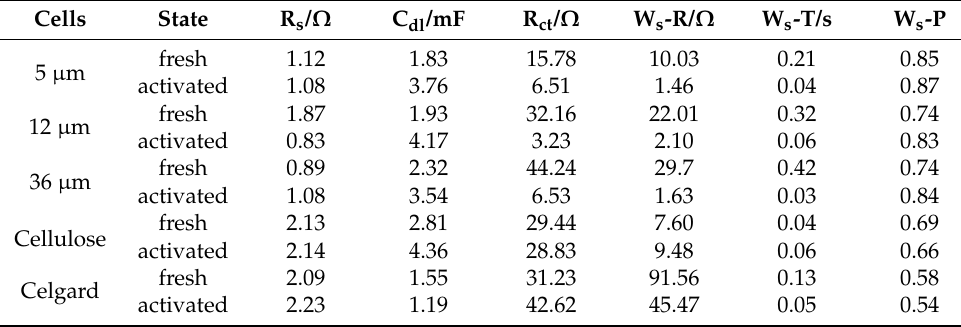
Figure 2. Nyquist plot of the cells with 5 µ m, 12 µ m, and 36 µ m PVDF-HFP gel polymer electrolyte, or cellulose and Celgard separator in the liquid electrolyte: ( a ) the fresh cell, ( b ) the activated cells. (the intercepts and semicircles in the high-frequency range are zoomed in the inset graphs). ( c ) The equivalent circuit for fitting the impedance spectra. ( d ) Cyclic polarization curves at 100 mV · s − 1 and ( e ) Galvanostatic charge–discharge curves at 8 A · g − 1 of the cells with 5 µ m, 12 µ m, and 36 µ m, PVDF-HFP gel polymer electrolyte, or cellulose and Celgard separator in the liquid electrolyte. ( f ) The specific capacitance of the cell at various scan rates. Table 1. Some fitting results of impedance